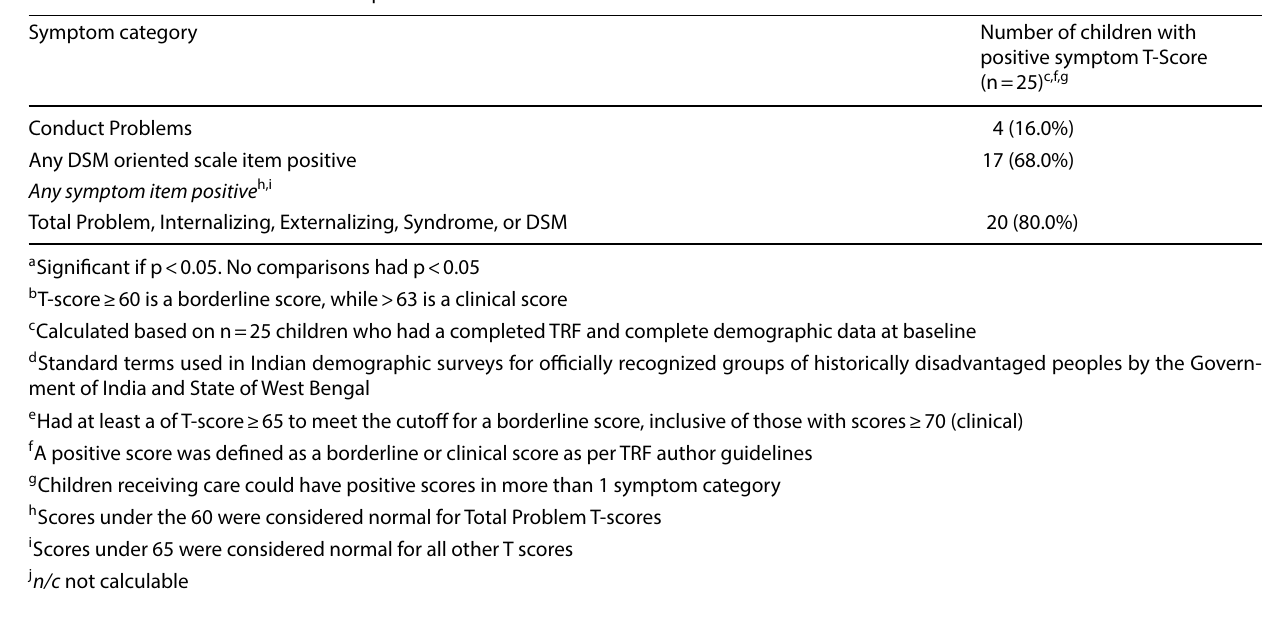
Table 4 Caregiver demographics and comparison of caregivers who did and did not complete a qualitative interview